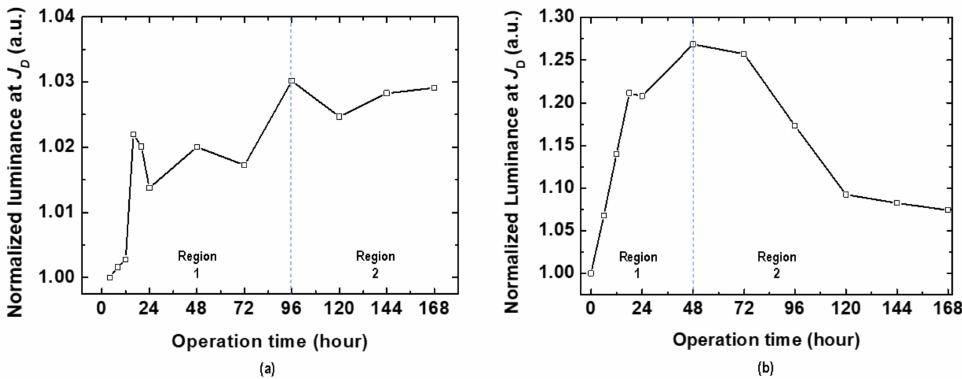
Figure 6. Luminance at J D as a function of operation time for the constant current stresses at ( a ) 2.5 × J D and ( b ) 15 × J D .